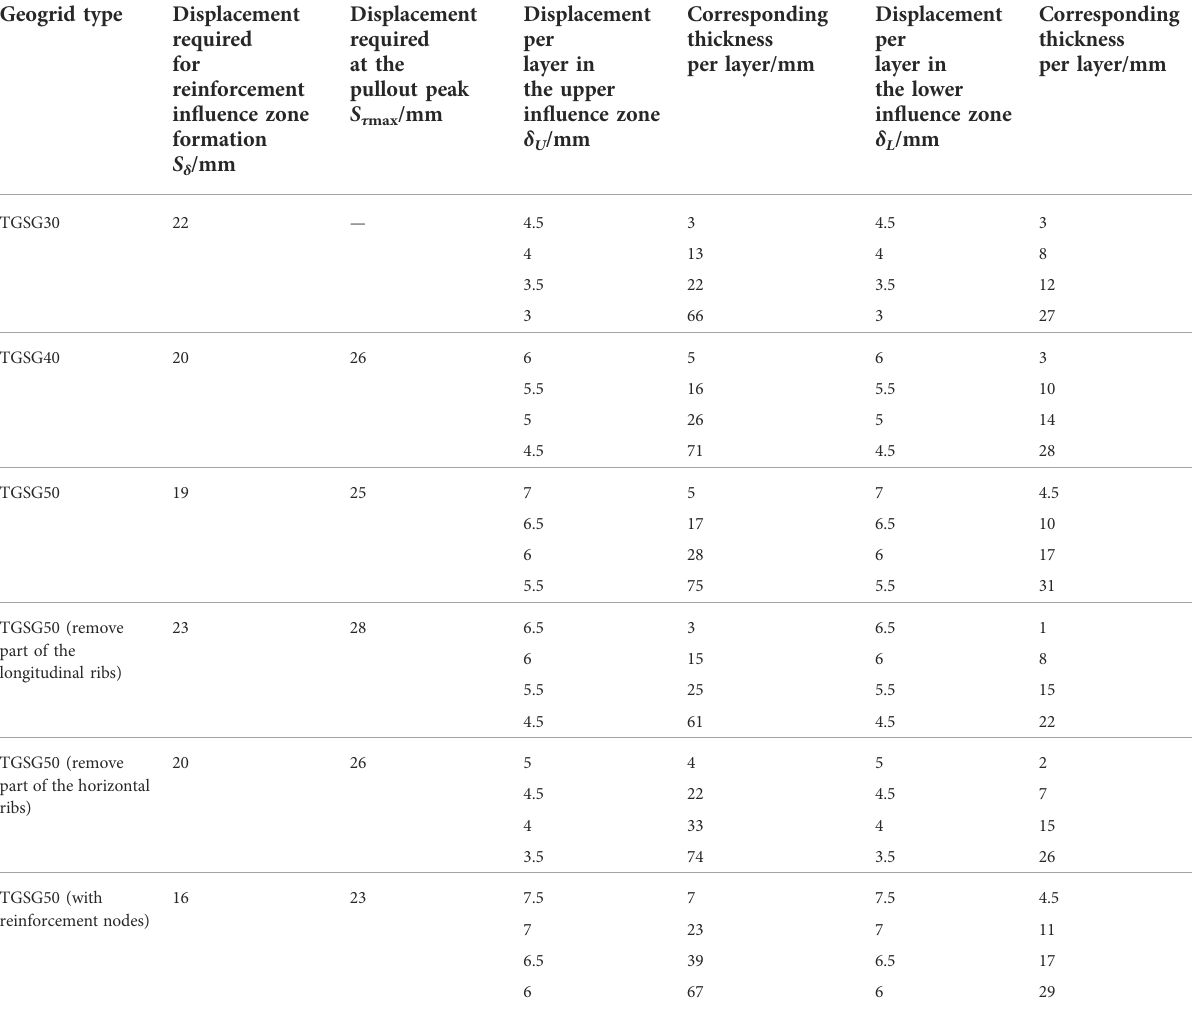
TABLE 5 Displacement and thickness of each layer under different types of grids (at the pullout peak). Geogrid